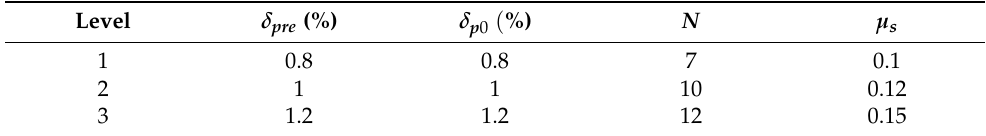
Table 1. Experimental factors and levels.